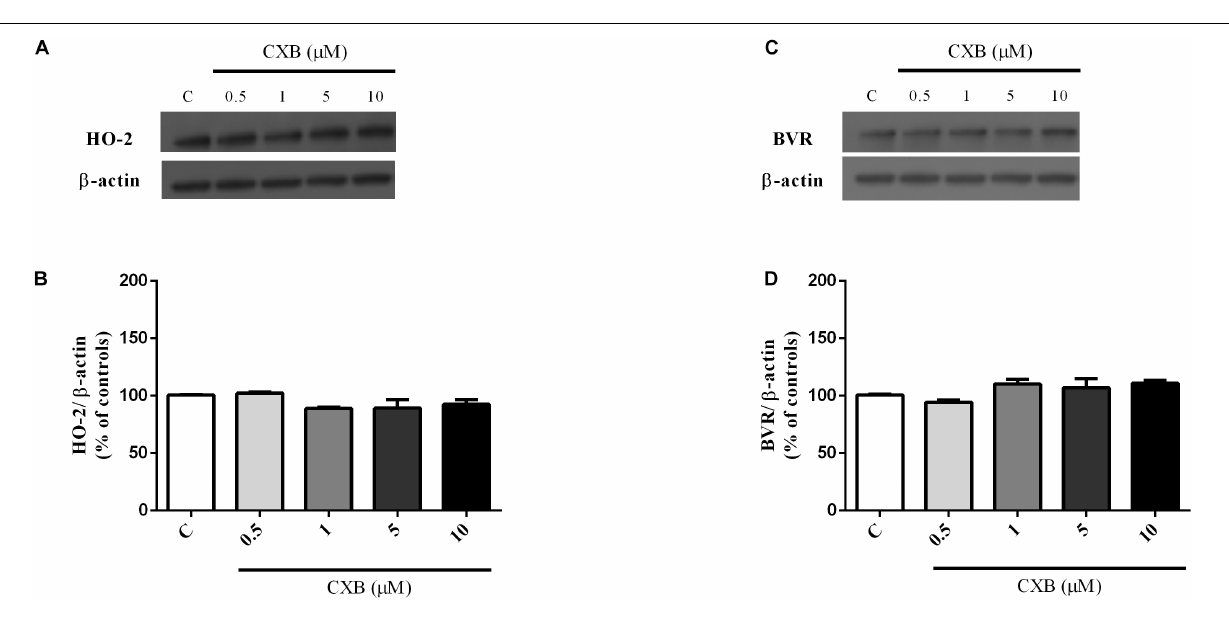
FIGURE 4 | Celecoxib (FA) effects on basal heme oxygenase-2 (HO-2) and biliverdin reductase (BVR) expression in SH-SY5Y neurons. SH-SY5Y cells were treated with CXB (0.5–10 µ M) for 1 h and then incubated with cell culture medium for 24 h. Following incubation, cells were harvested and Western Blot was performed as described in Section “Materials and Methods.” (A,C) Show representative gels evaluating HO-2 and BVR protein expression. Bar graphs represent the quantification of HO-2 and BVR protein levels normalized for β -actin expression. Data are expressed as mean ± SEM of 4/5 replicates per group and analyzed by one-way ANOVA followed by Tukey’s test: P >